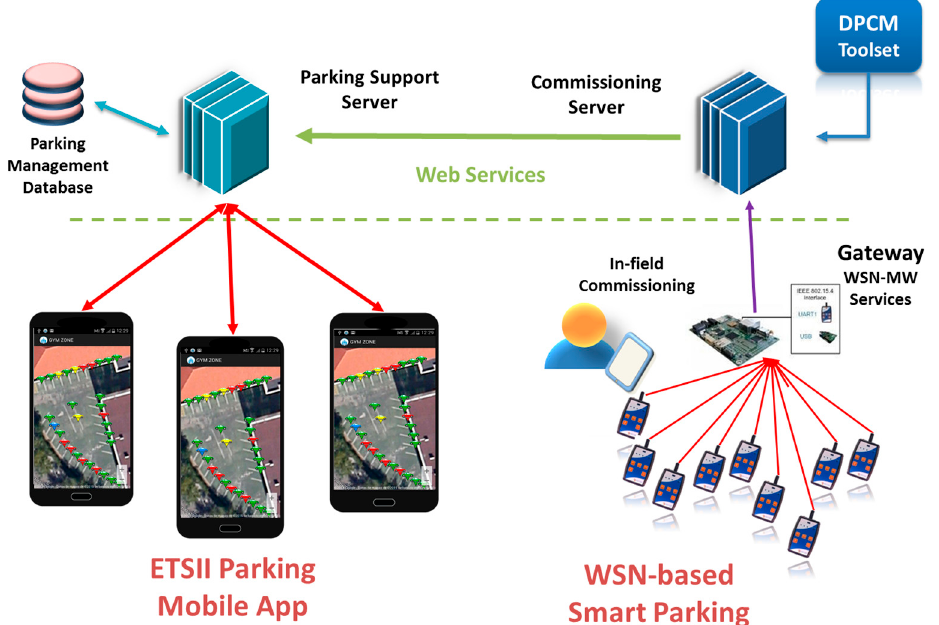
Figure 25. Underlying structure of the smart parking user application.